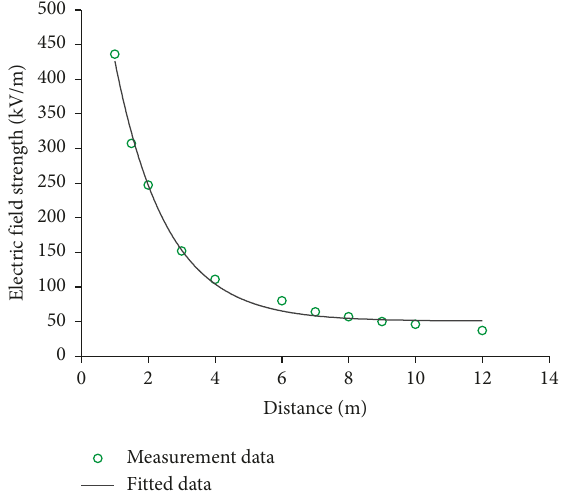
Figure 4: Relation of radiation electric field strength to